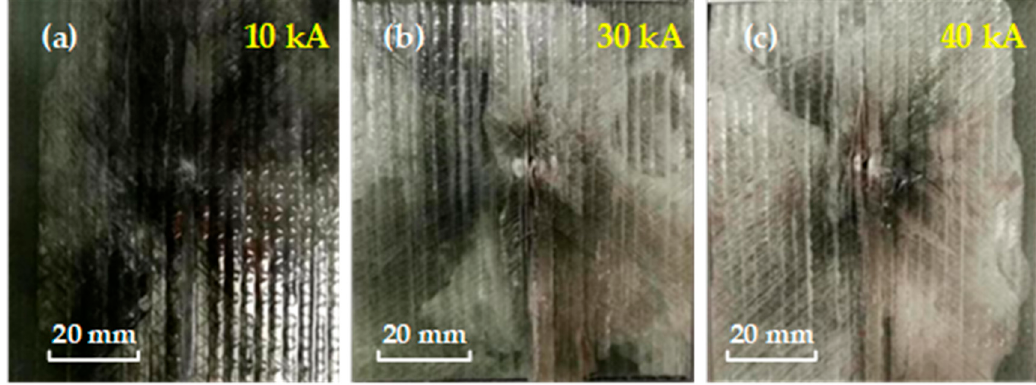
Figure 15. Ablation damages of GFRCs under different current amplitudes, ( a ) 10 kA, ( b ) 30 kA, ( c ) 40 kA.